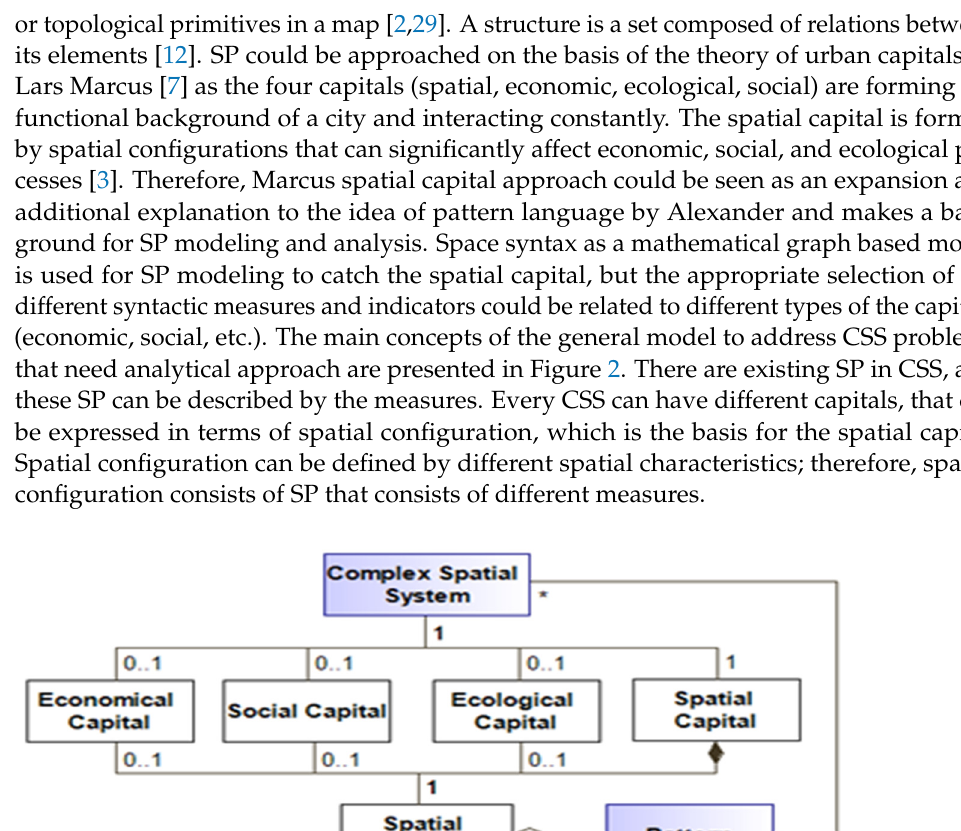
Figure 3. Types of SP attributes (UML class diagram). The elaborated model of SP is presented in Figure 4, and it has some significant changes. First, the class PAttribute for non-spatial SP attributes is created; it defines de- scriptive SP attributes (any descriptive SP characteristic, such as origin or scientific justi-